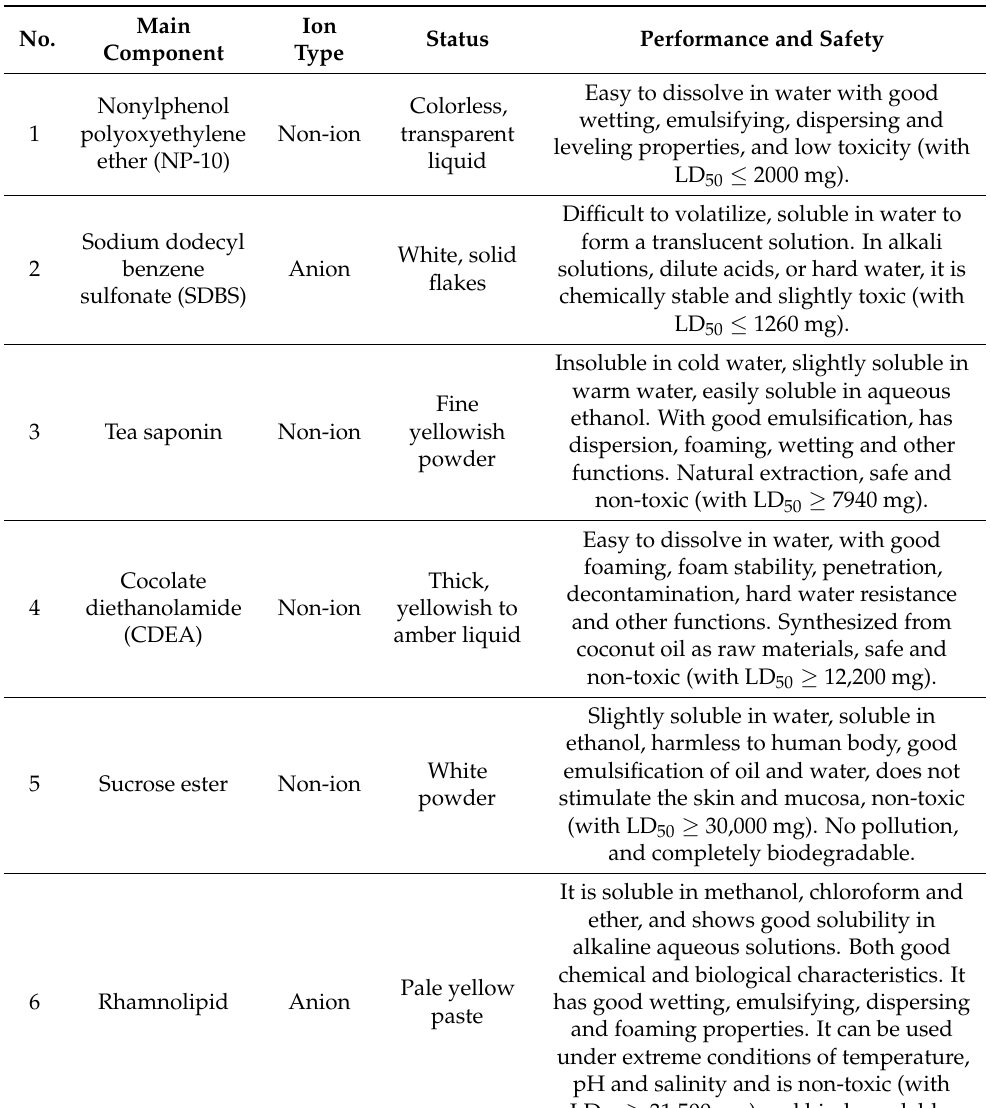
Table 4. Types and basic properties of